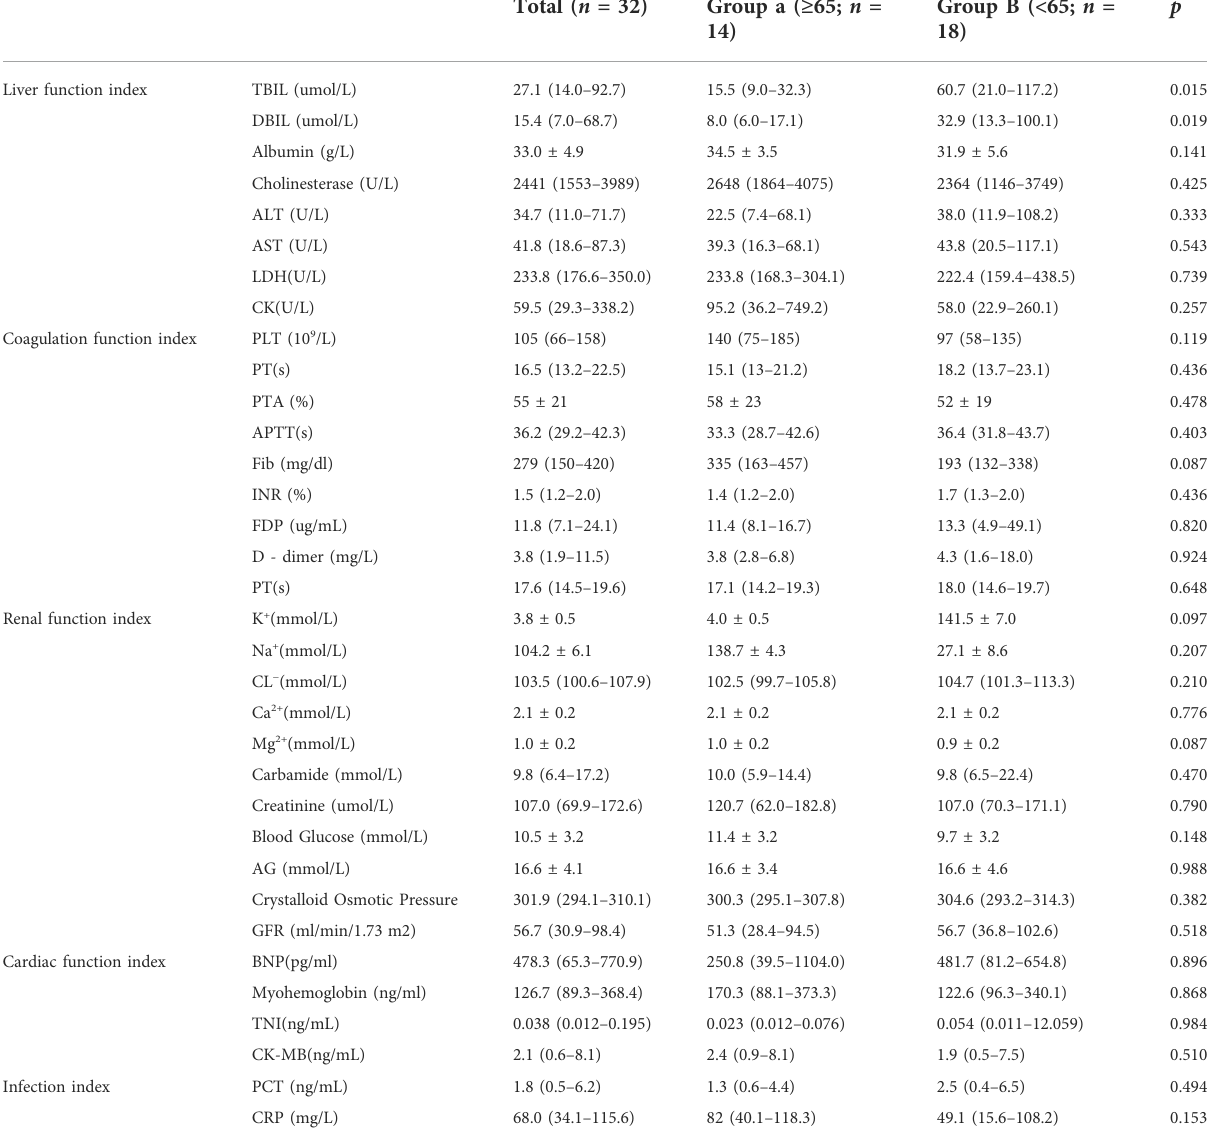
TABLE 2 Visceral function measures in abdominal sepsis patients of different age groups. Total ( n = 32) Group a ( ≥ 65; n =